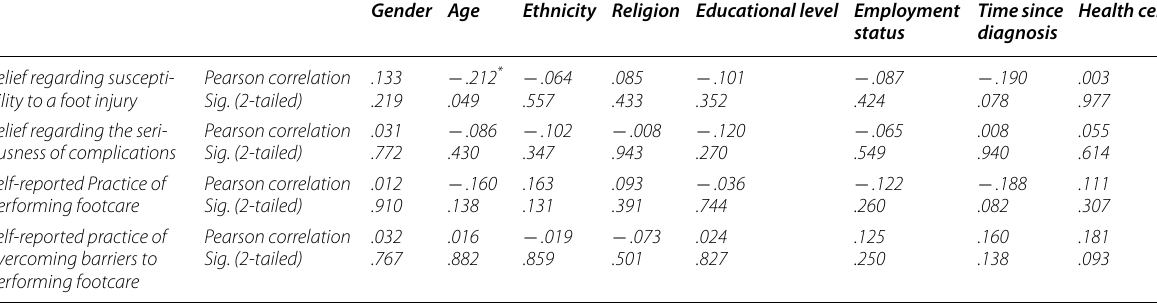
*Correlation is significant at the 0.05 level (2‑tailed) **Correlation is significant at the 0.01 level (2‑tailed)